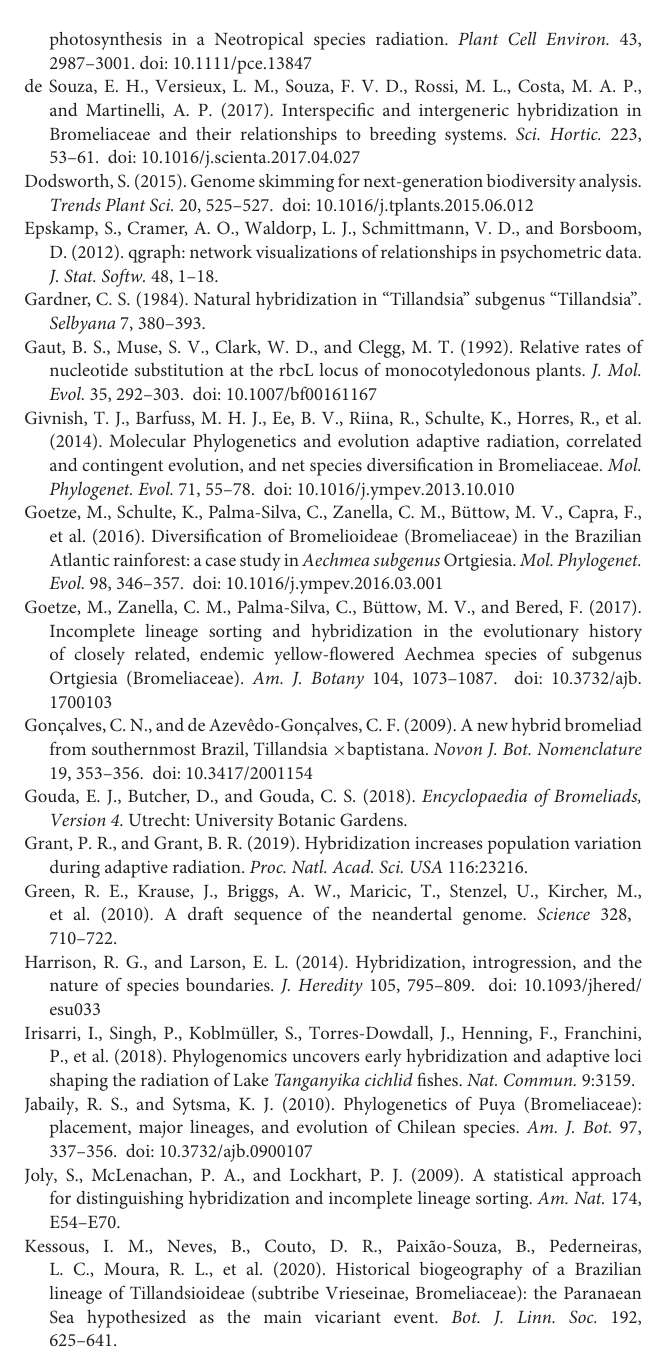
Supplementary Figure 2 | Phylogenetic tree of core Tillandsioideae inferred with RaxML using the concatenated chloroplast SNPs. Supplementary Figure 3 | Phylogenetic tree of core Tillandsioideae inferred with RaxML using the concatenated nuclear SNPs. Supplementary Figure 4 | Phylogenetic tree of core Tillandsioideae inferred with SVDquartet using the concatenated nuclear SNPs. Supplementary Table 1 | List of all significant triplets identified by